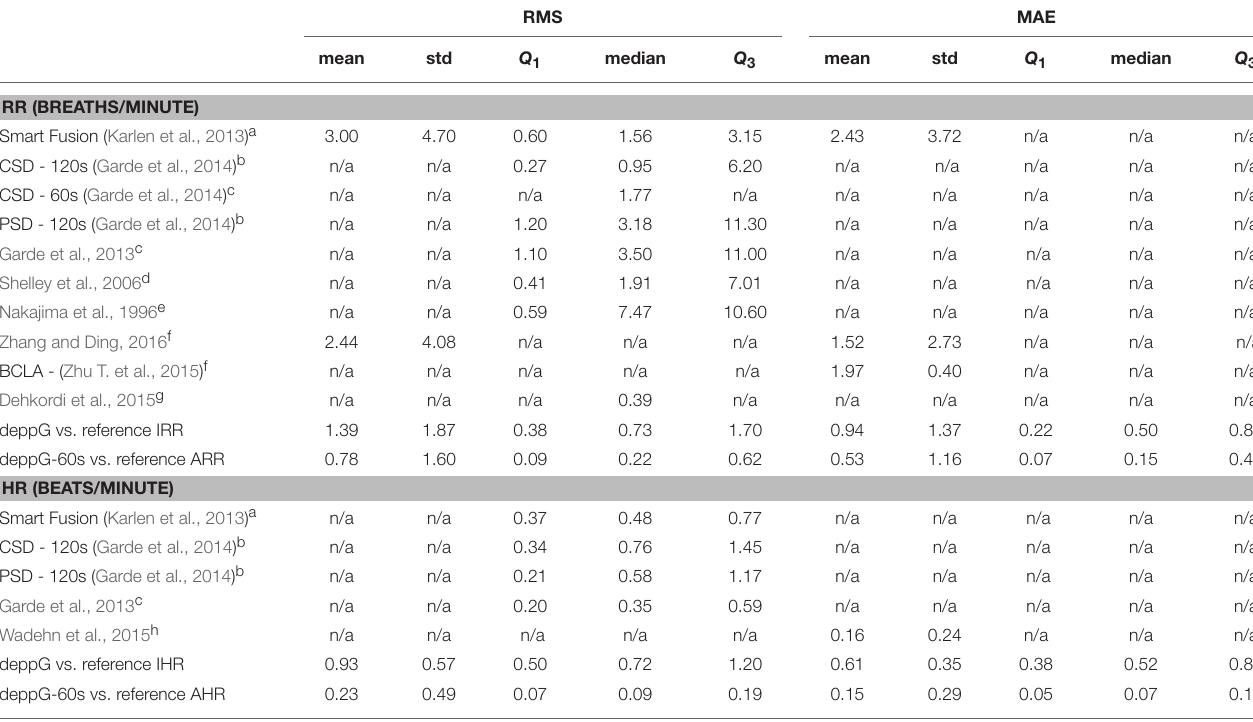
TABLE 1 | Summary of root mean square error (RMS) and mean absolute error (MAE) of the respiratory rate (RR) and heart rate (HR) estimation for the Capnobase benchmark